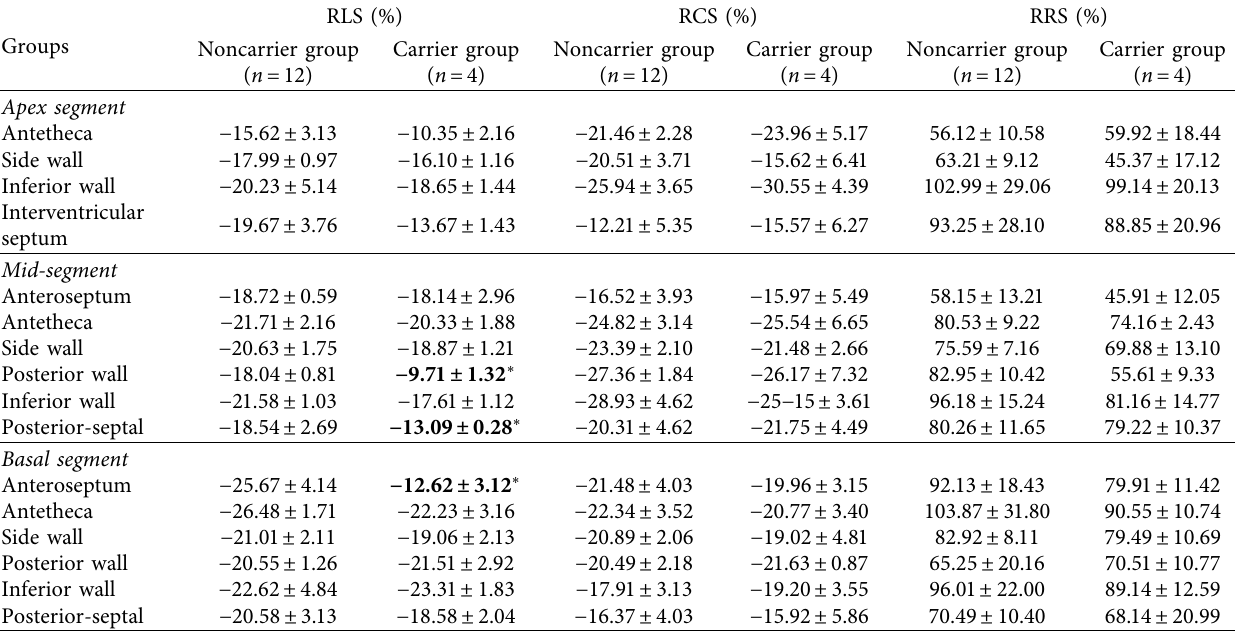
Table 4: Comparison of three-dimensional strain indexes of 16 segments between the two groups ( x ± s ).